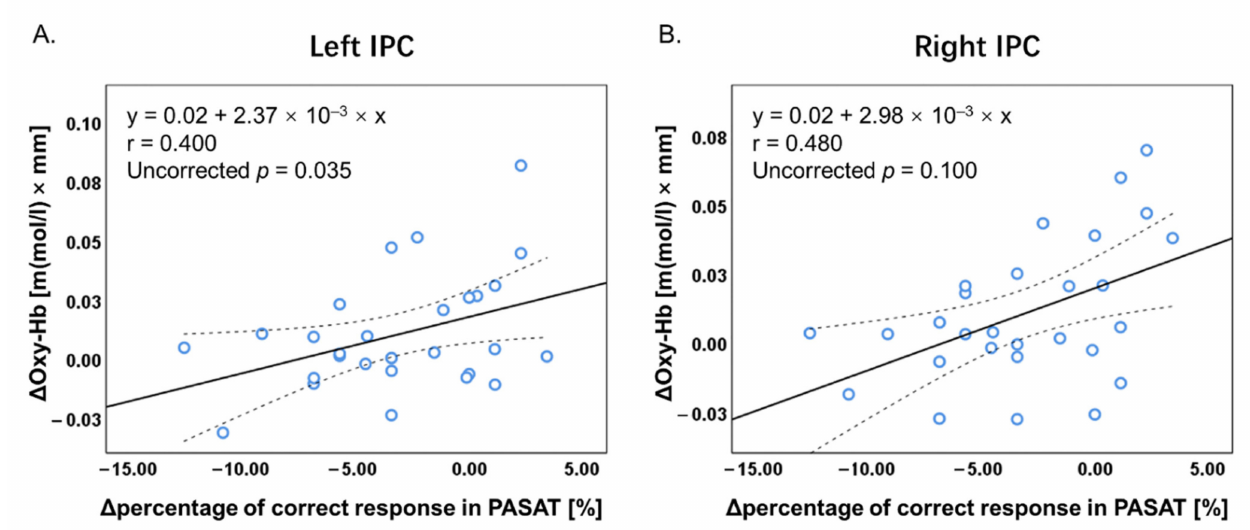
Figure 7. Scatter plots for ∆ percentage of correct responses in PASAT and ∆ Oxy-Hb concentration in the bilateral IPC. ( A ) A significant positive correlation was found between ∆ percentage of correct responses and ∆ Oxy-Hb concentration in left IPC in the PASAT. ( B ) A significant positive correlation was found between ∆ percentage of correct responses and ∆ Oxy-Hb concentration in right IPC in the PASAT. Oxy-Hb, oxygenated hemoglobin; ROI, region of interest; IPC, inferior parietal cortex; PASAT, Paced Auditory Serial Addition